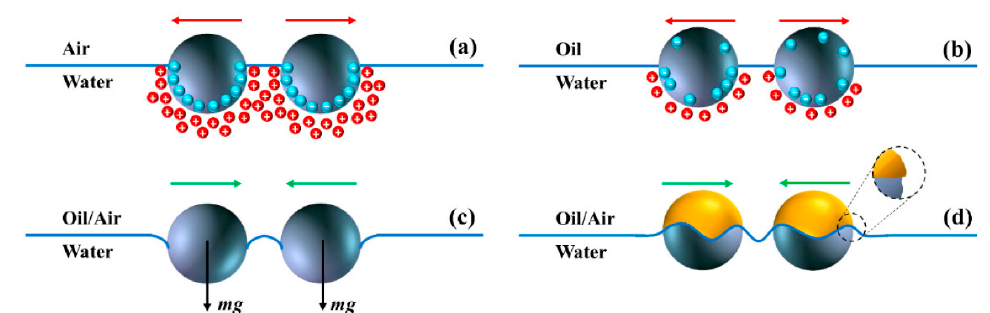
3 of 27 Figure 1. Anisotropic Janus particles with a variety of structural conformations. ( A – C ) SEM images